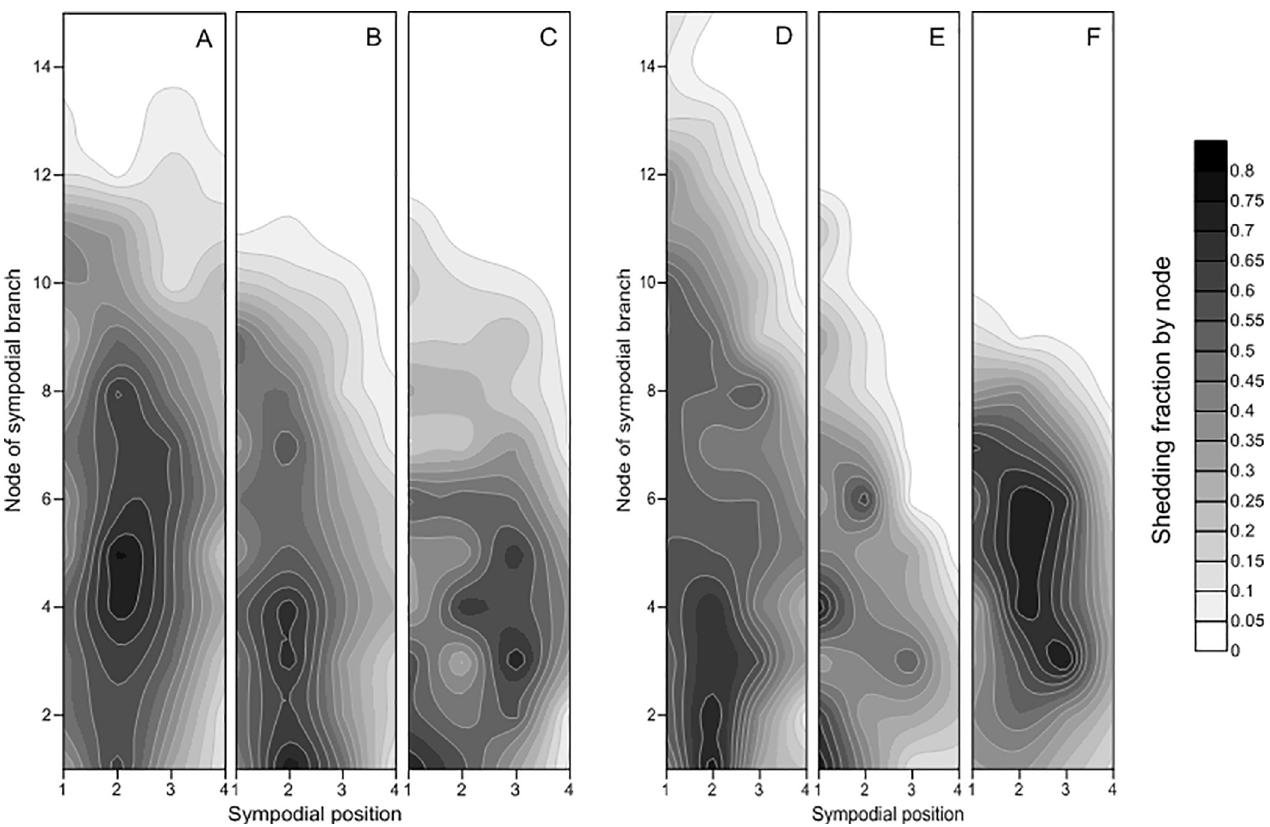
Fig 5. Shedding rate by node in the different planting patterns at 100 DAS in 2016 and 2017. Note: A, B, and C represent the cotton monoculture (CM) system, the cotton/wheat intercropping (CWI) system, and the system in which cotton was directly seeded after wheat (CWD), respectively, in 2016; D, E, and F represent the cotton monoculture (CM) system, the cotton/wheat intercropping (CWI) system, and the system in which cotton was directly seeded after wheat (CWD), respectively, in 2017.